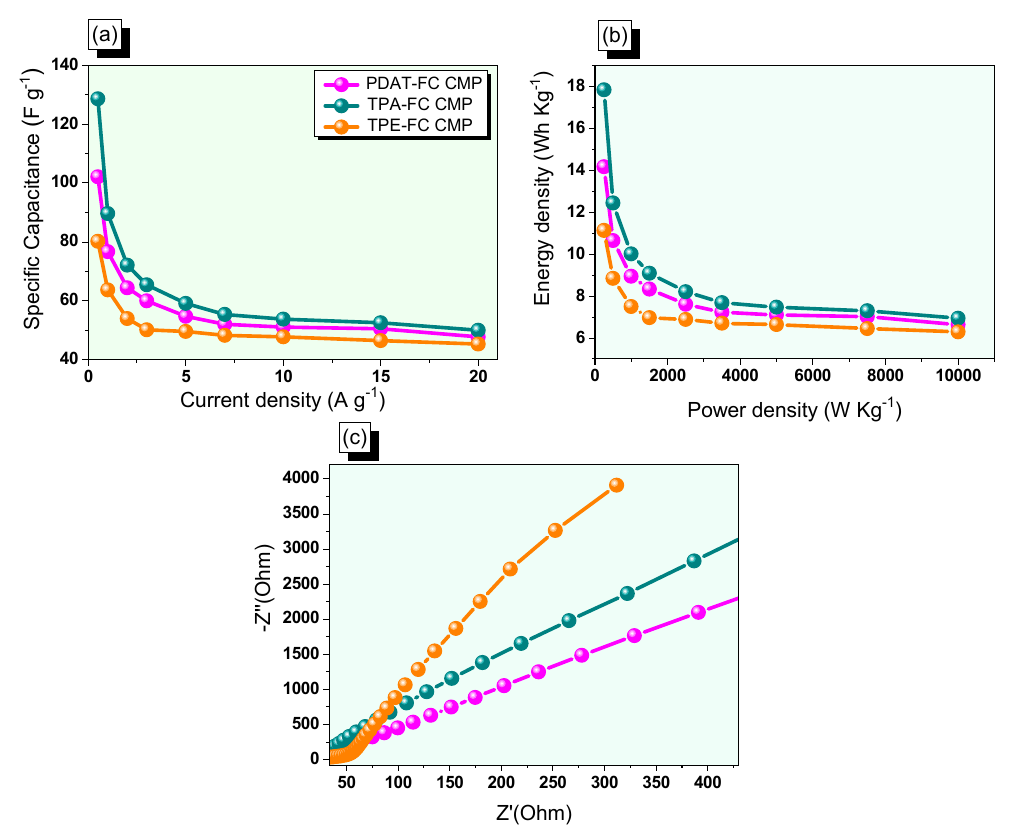
Figure 5. ( a ) Specific capacitance, ( b ) Ragone, and ( c ) Nyquist profiles of PDAT-FC, TPA-FC, and TPE-FC CMPs.